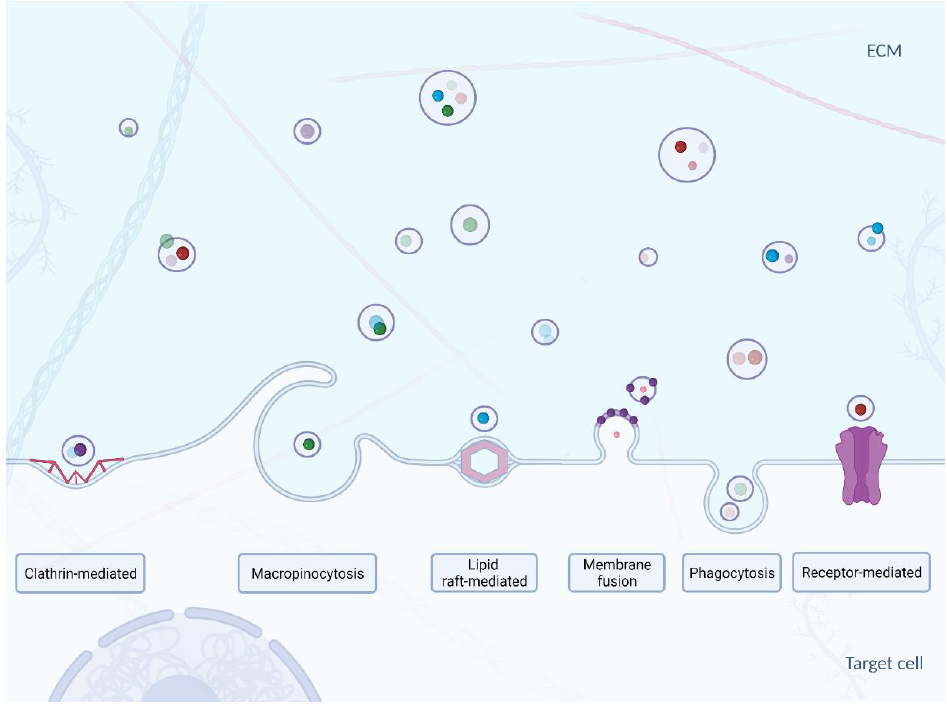
Figure 3. Uptake mechanisms of exosomes – clathrin-mediated [84], macropinocythosis [85], lipid raft-mediated [86], membrane fusion [87], phagocythosis [88] and receptor-mediated [89]. Created with BioRender.com.